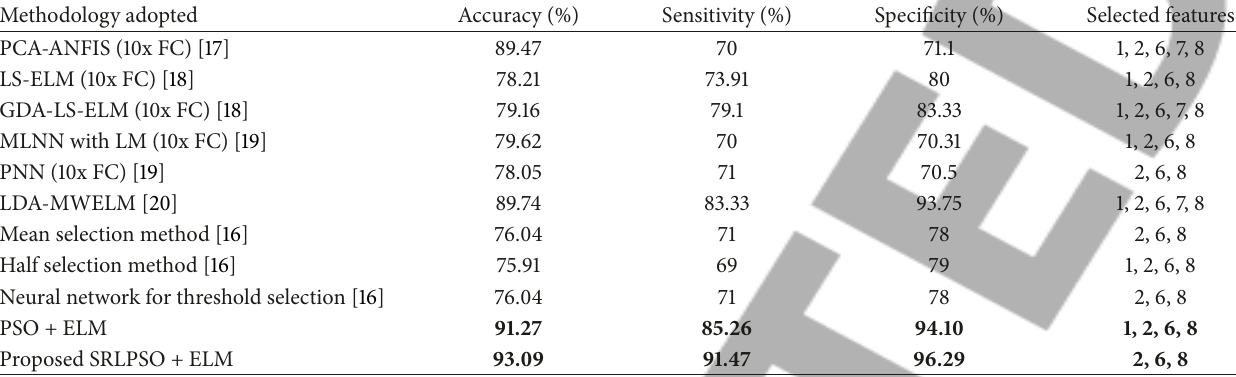
Table 4: Classification results with Pima Indians Diabetes dataset.